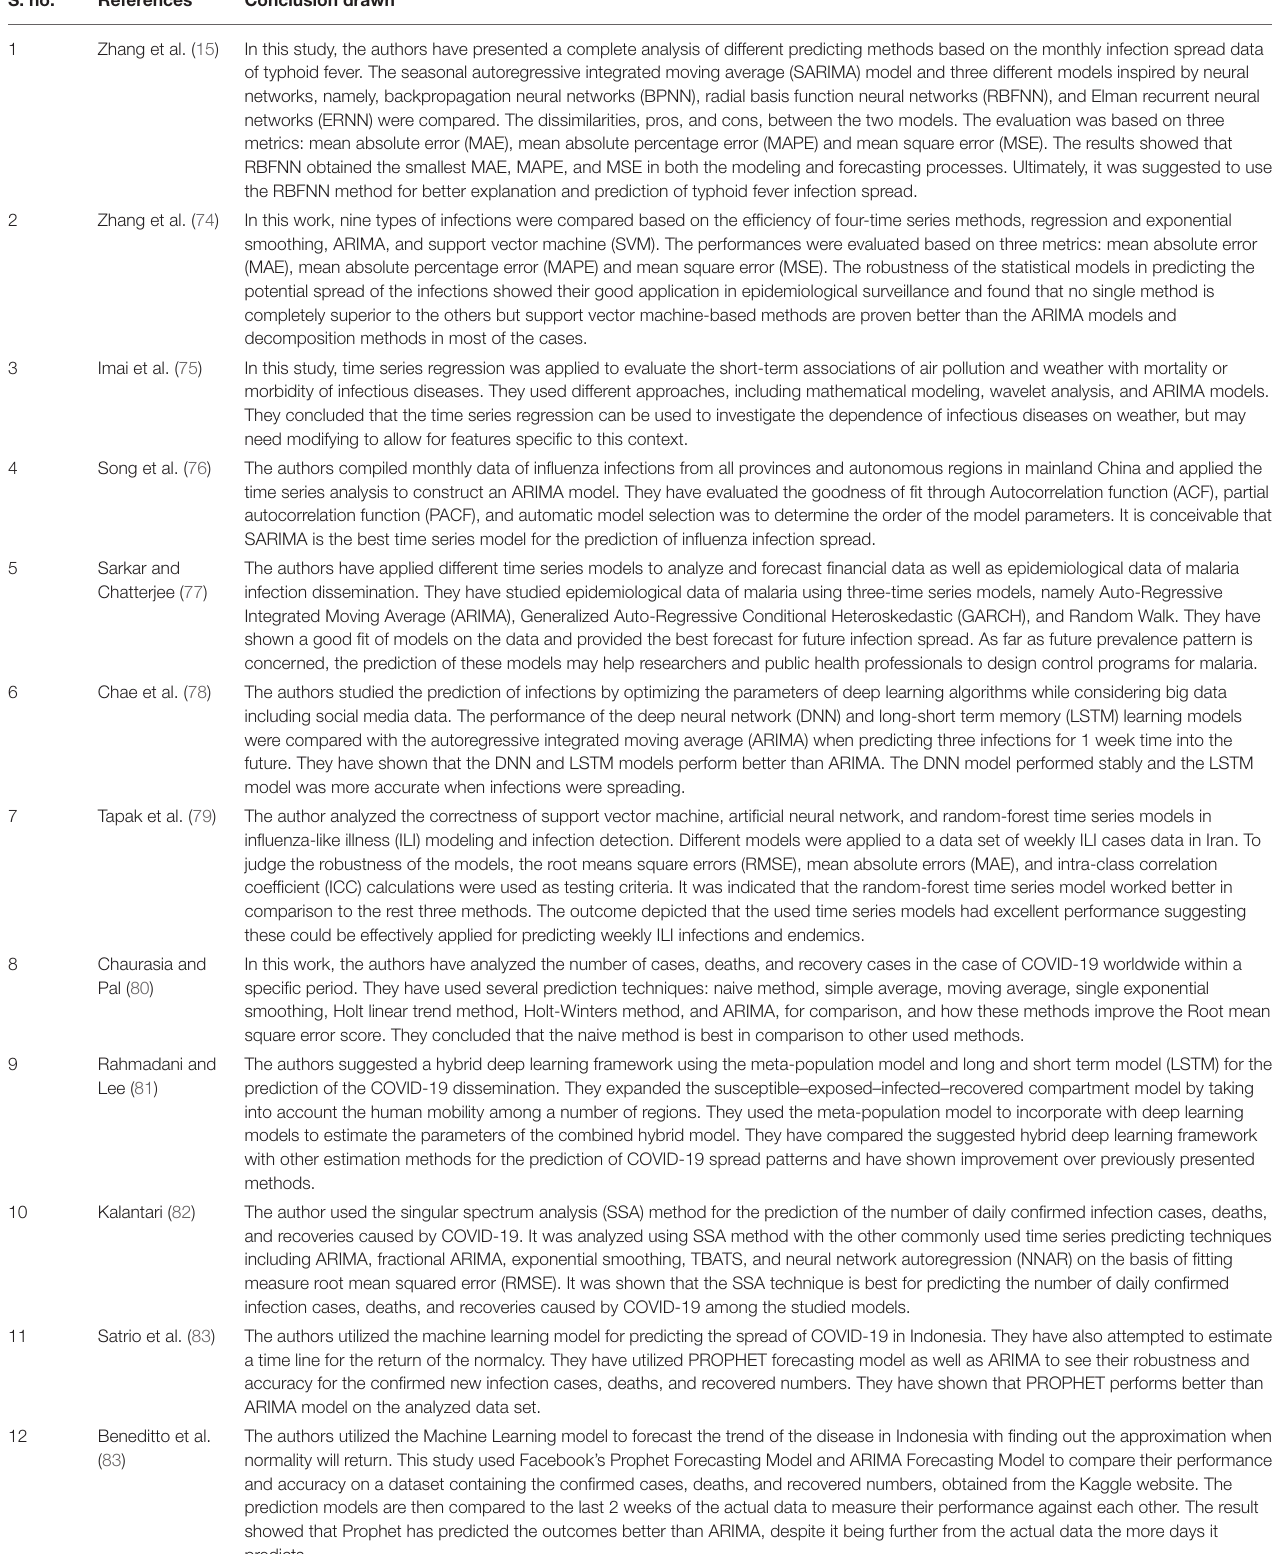
TABLE 3 | Different time series regression models for different infectious diseases. S.